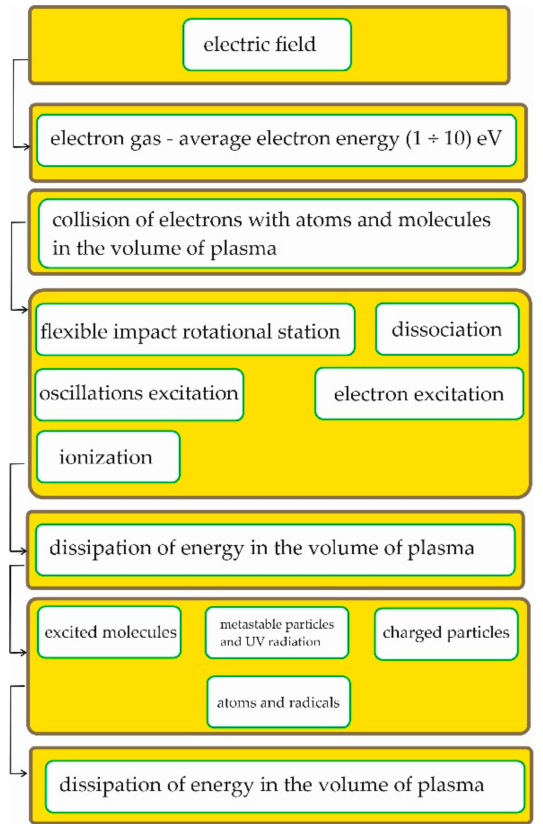
Figure 1. Energy transformation and the phenomena accompanying the generation of non- thermal